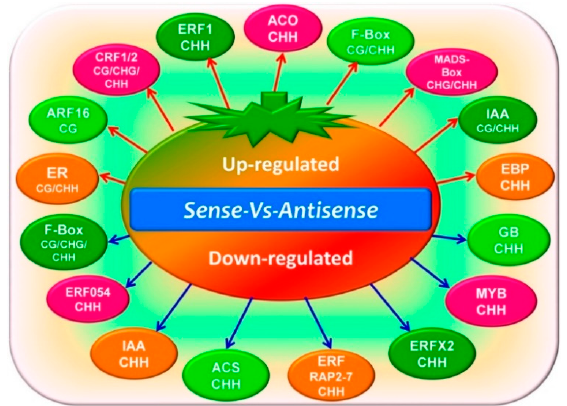
Figure 8. The DMR and differentially expressed genes (DEG) conjoint analysis of related genes involved in the ethylene pathway. Several genes of different methylation types involved in ethylene synthesis and signal transduction were identified.